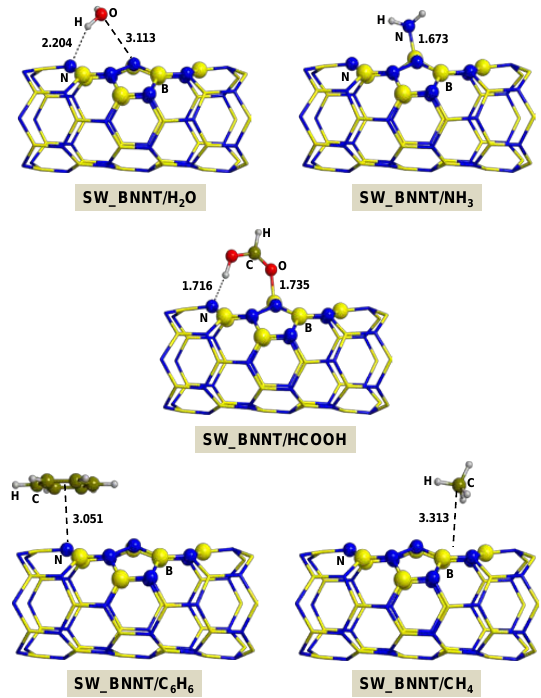
Figure 3. B3LYP-D2* optimized structures of the probe molecules interacting with SW_ BNNT. Bond distances are in Å. The distances for SW_BNNT/C 6 H 6 are that between the centroid of the aromatic ring and the plane defined by the closest BN heptagon ring; for CH 4 , they are between the C atom and the plane defined by the closest BN heptagon ring.